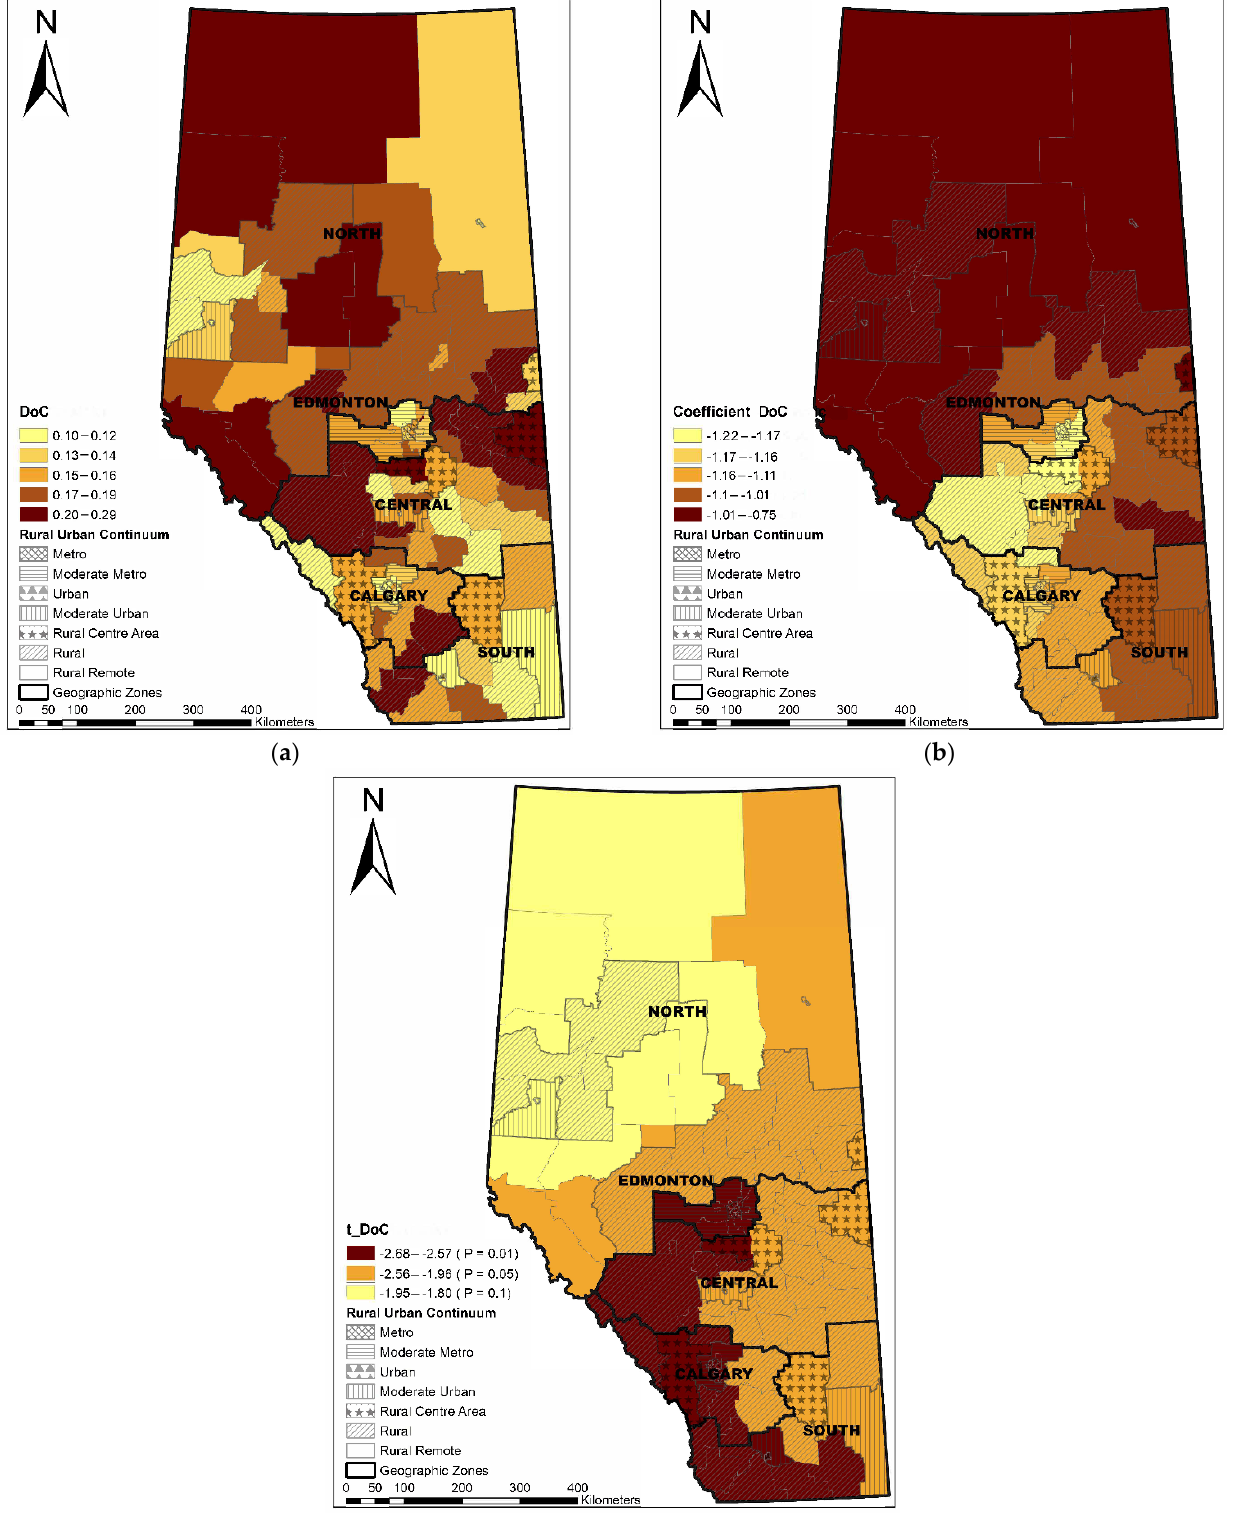
Figure 6. Distribution of discontinuity of care ( a ), coefficient of continuity of care ( b ), and significance of coefficient ( c ).